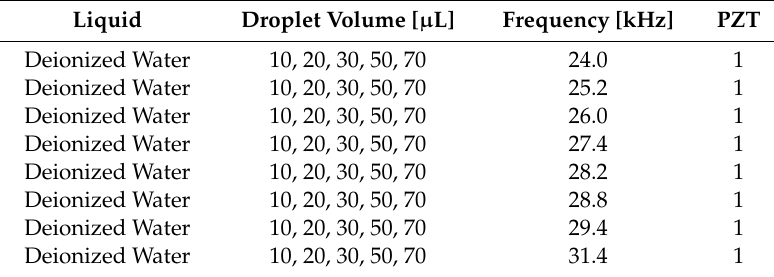
Table A1. Testing parameters used for the experiments conducted with deionized water to investigate material property e ff